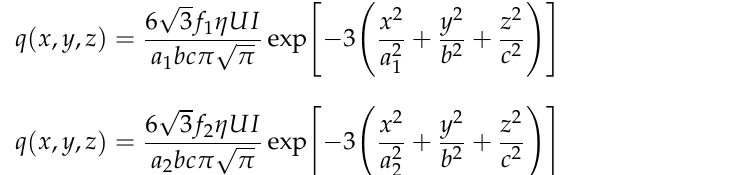
Figure 6. Diagram of welding boundary conditions.